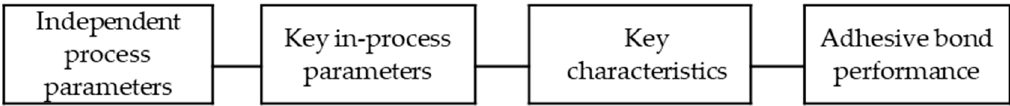
Figure 15. Illustration between various parameters and the final performance of a new adhesively- bonded system.